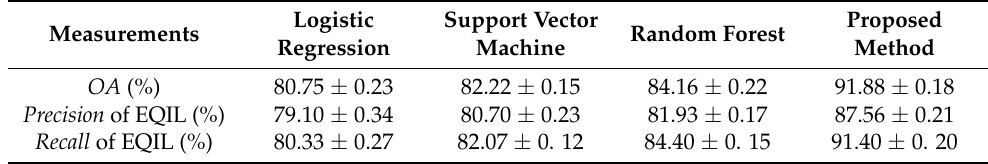
Table 5. Prediction result assessment with different framework